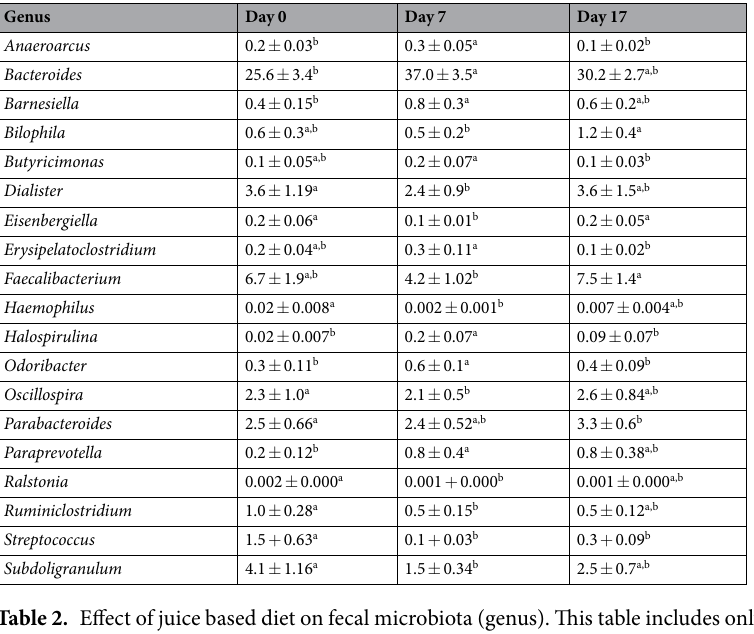
Table 2. Effect of juice based diet on fecal microbiota (genus). This table includes only significantly altered bacteria. Supplementary Table S2 includes bacteria that did not change significantly. Data presents proportions of bacteria as percent of total count. Values are mean ± SEMs (n = 20). a,b Labeled means without a common superscript letter differ, p < 0.05.